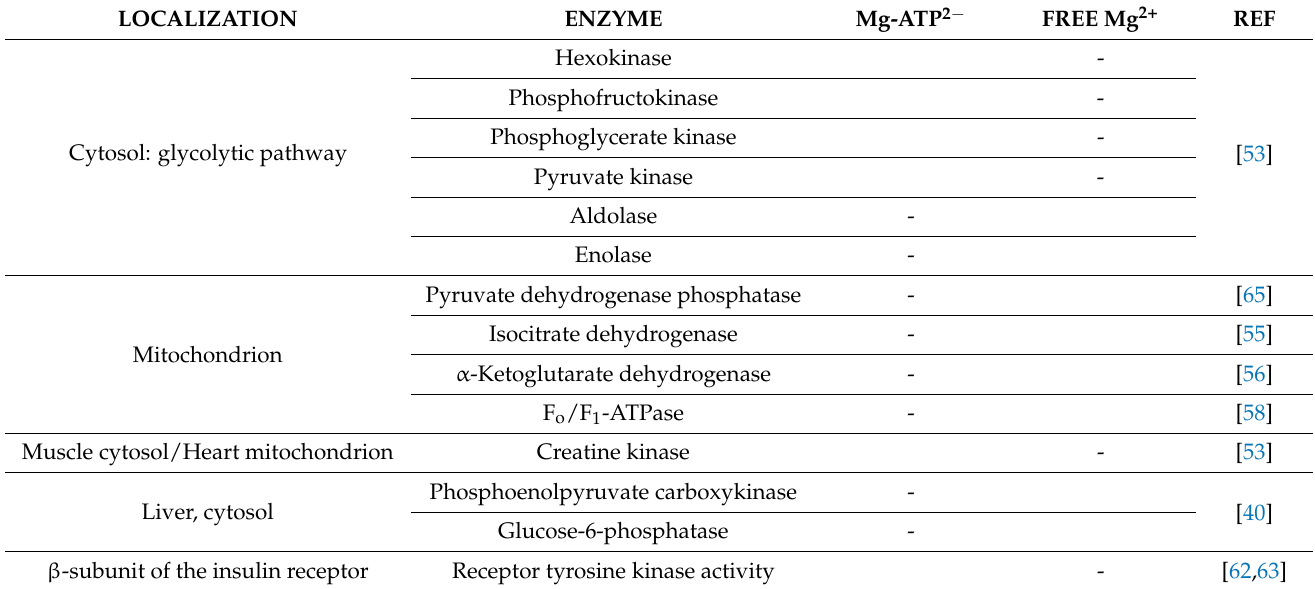
Table 1. Enzymes requiring